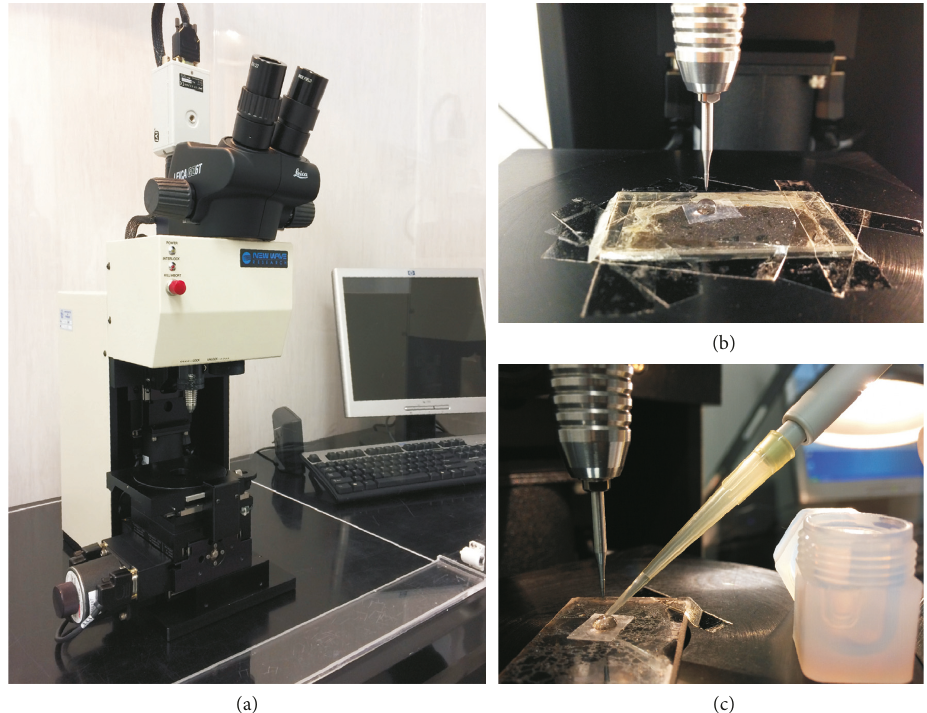
Figure 1: (a) The New Wave-Merchantek Micromill device operating at the Department of Earth Sciences–University of Firenze; (b) image of a petrographic polish thick section fixed on the sample stage under the tungsten carbide drilling bit that is locked into the milling chuck. A Milli-Q droplet constrained by the Parafilm is placed on the section in order to collect the powder during the drill; and (c) sample slurry recovery from the drilled surface into the digestion beaker.